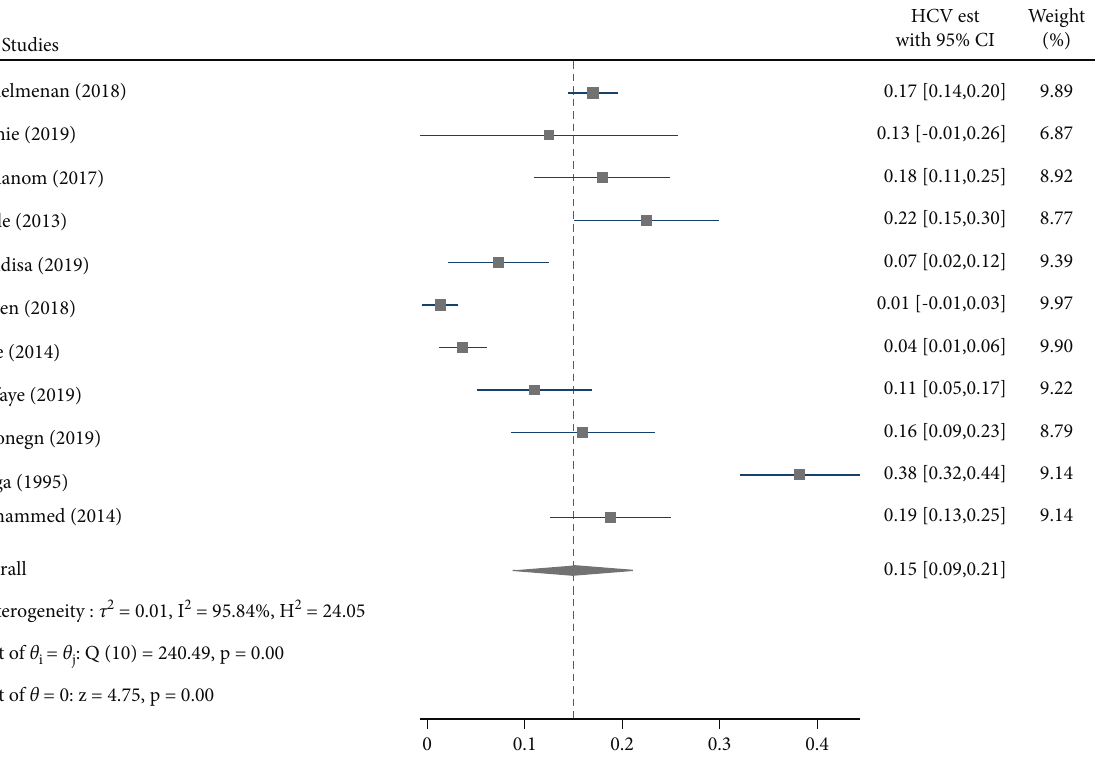
Figure 7: Forest plot depicting the estimated proportion of HCV infection among chronic liver disease patients in Ethiopia,